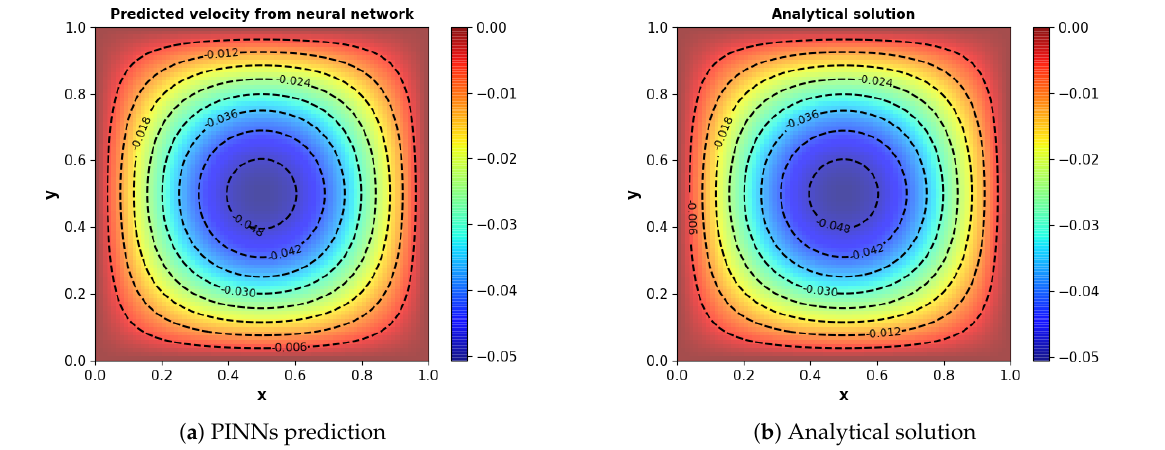
Figure 13. Comparisons between the PINN prediction ( a ) and the analytical solution ( b